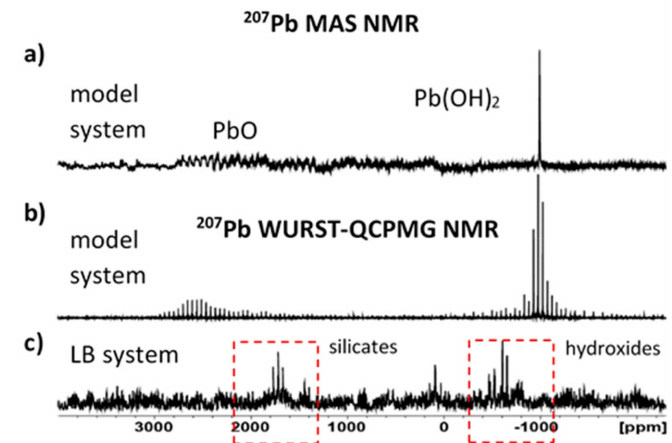
Figure 8. 207 Pb solid-state NMR spectra. ( a ) Standard 207 Pb MAS NMR spectrum of a reference mixture